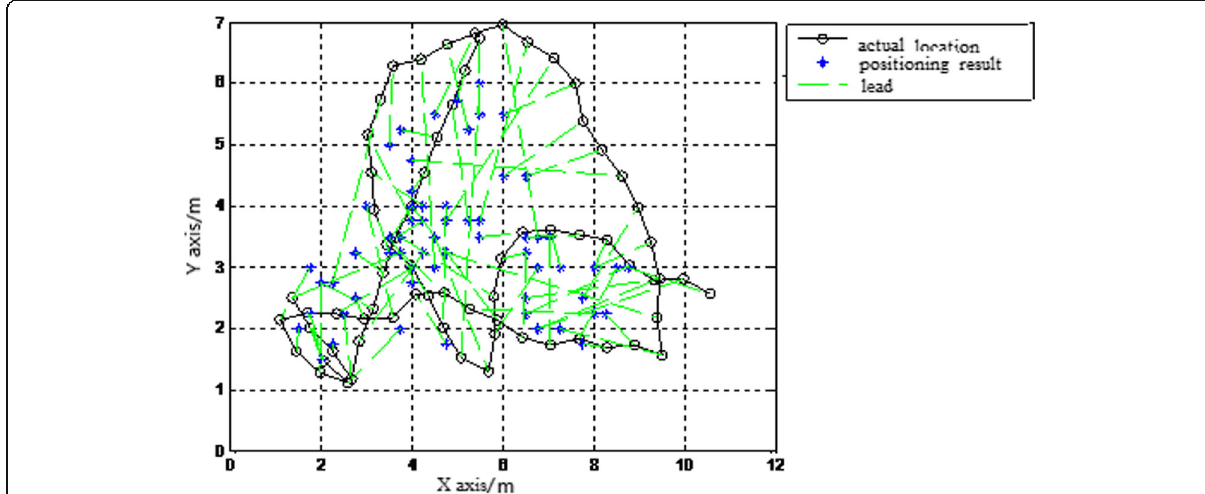
Fig. 8 The result of positioning analysts based on cosine similarity